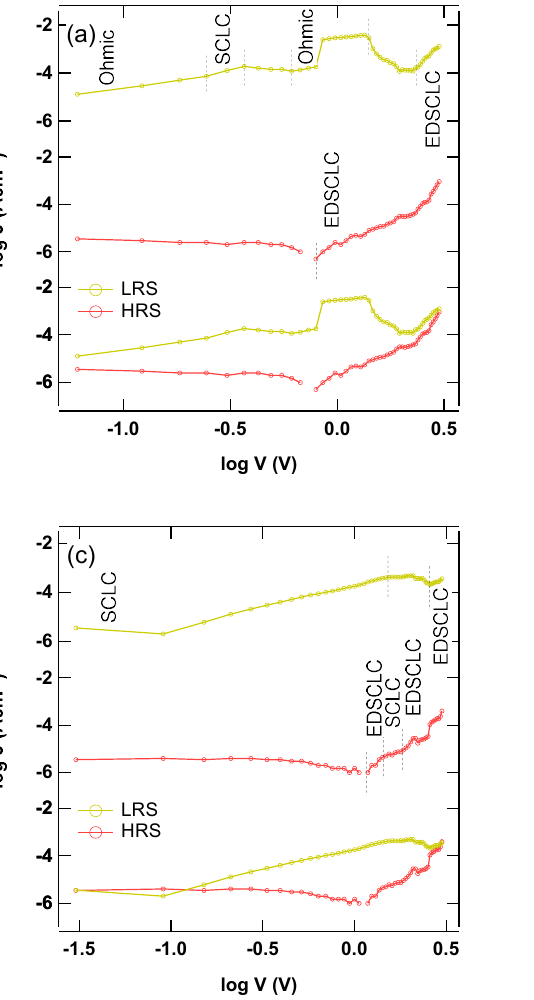
Figure 2. Plot of log J vs. log V of the ITO / ReO 3 @ReS 2 / Al for the initial scan under ( a ) negative and ( b ) positive bias; and for the fifth consecutive scan under ( c ) negative and ( d ) positive bias. Sweeping voltage range: ±3 V, I cc : 1 × 10 −2 A, and frequency ( f ): 0.6 Hz.